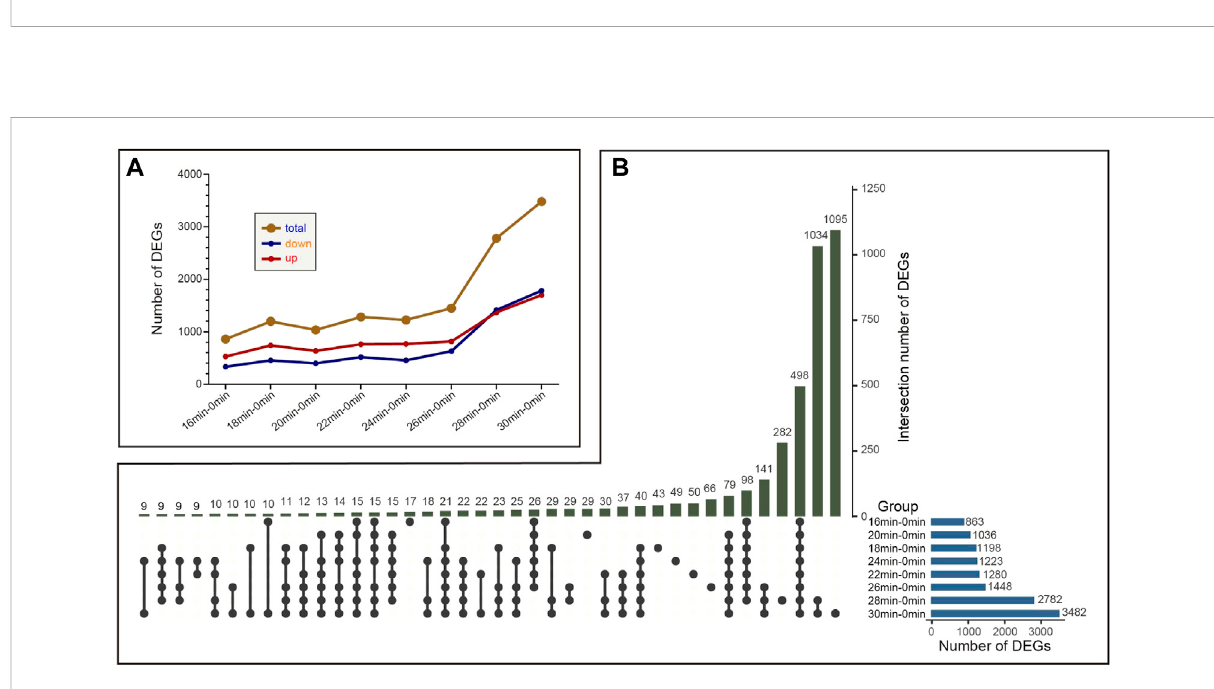
FIGURE 4 Thevariationtrendofthenumberofdifferentiallyexpressedgenes(DEGs)between0 mingroupanddifferentischemiagroups. (A) Thevariation trend of the number of DEGs among different compared groups (B) The number of intersected DEGs between different compared groups. The number above stands for the number of DEGs that intersect between different